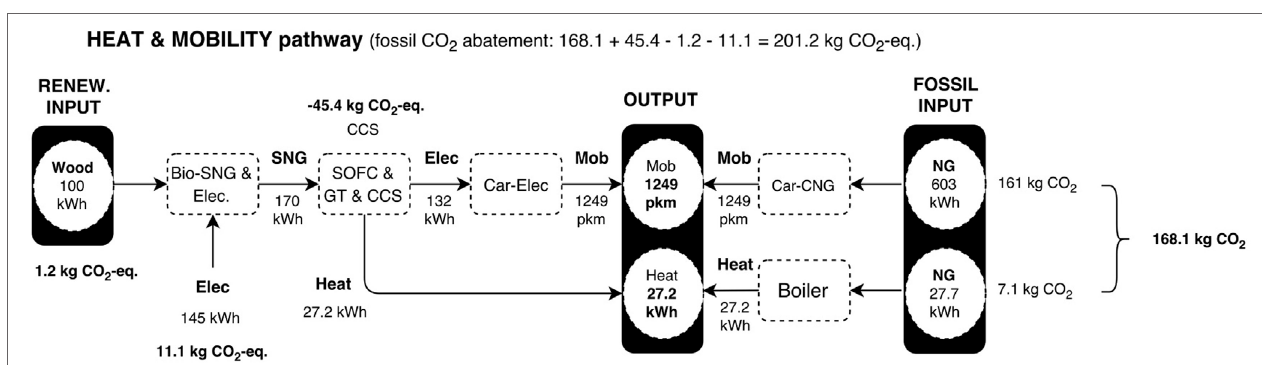
FigUre 7 | Substitution pathway with the maximum CO 2 abatement potential